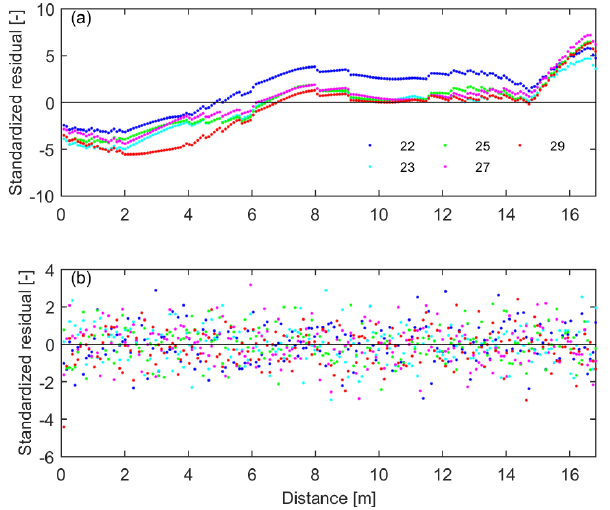
Figure 5. Impacts of errors on the inverse estimation in the field study and in the synthetic study. (a) Structural pattern of standard- ized residuals in the field study indicates notable structural errors, apart from Gaussian distributed error at each point. (b) Gaussian distributed standardized residuals in the synthetic study.